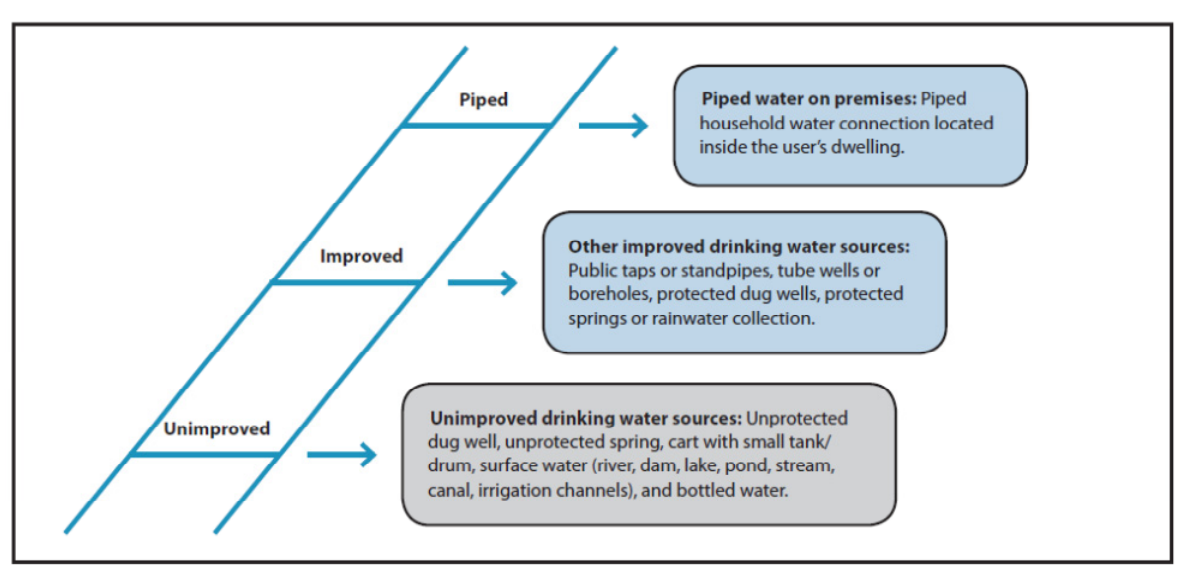
Figure 2. The WHO-UNICEF JMP water serivce ladder (Adapted from [34] with